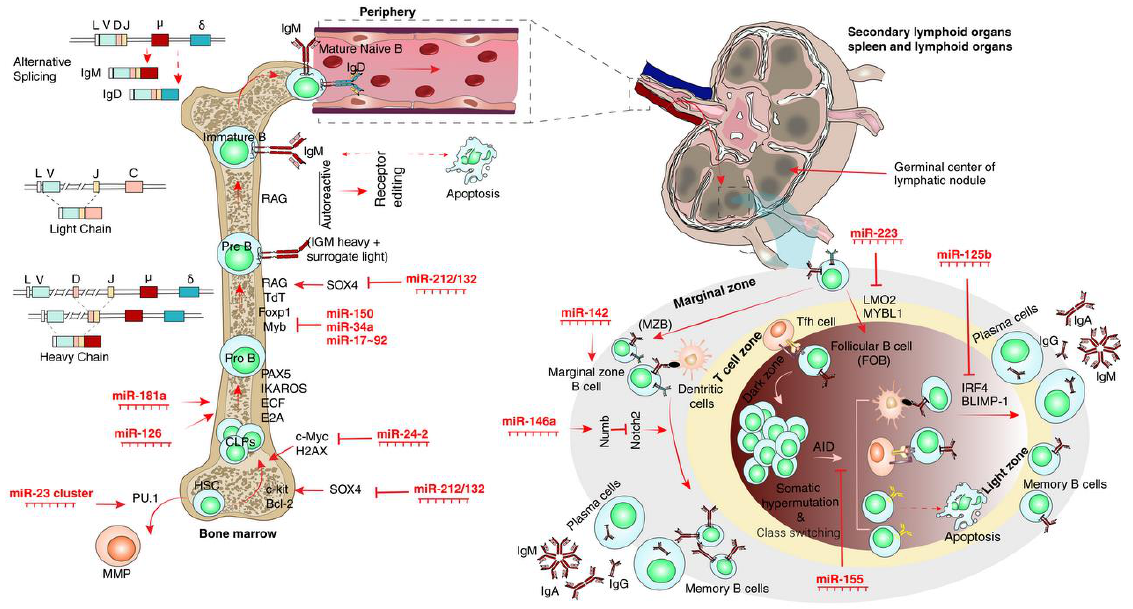
Figure 4. MiRNAs’ roles in B-cell commitment. ( Left ): The maturation process of B-cells from CLP in bone marrow during V(D)J recombination and the role of miRNAs in each step. ( Right ): Role of miRNAs in the differentiation of marginal zone B-cell (MZB) and follicular B-cell (FOB) in peripheral lymphoid organs. Abbreviations: H2AX: H2A histone family member X; TdT: Terminal Deoxynucleotidyl Transferase.